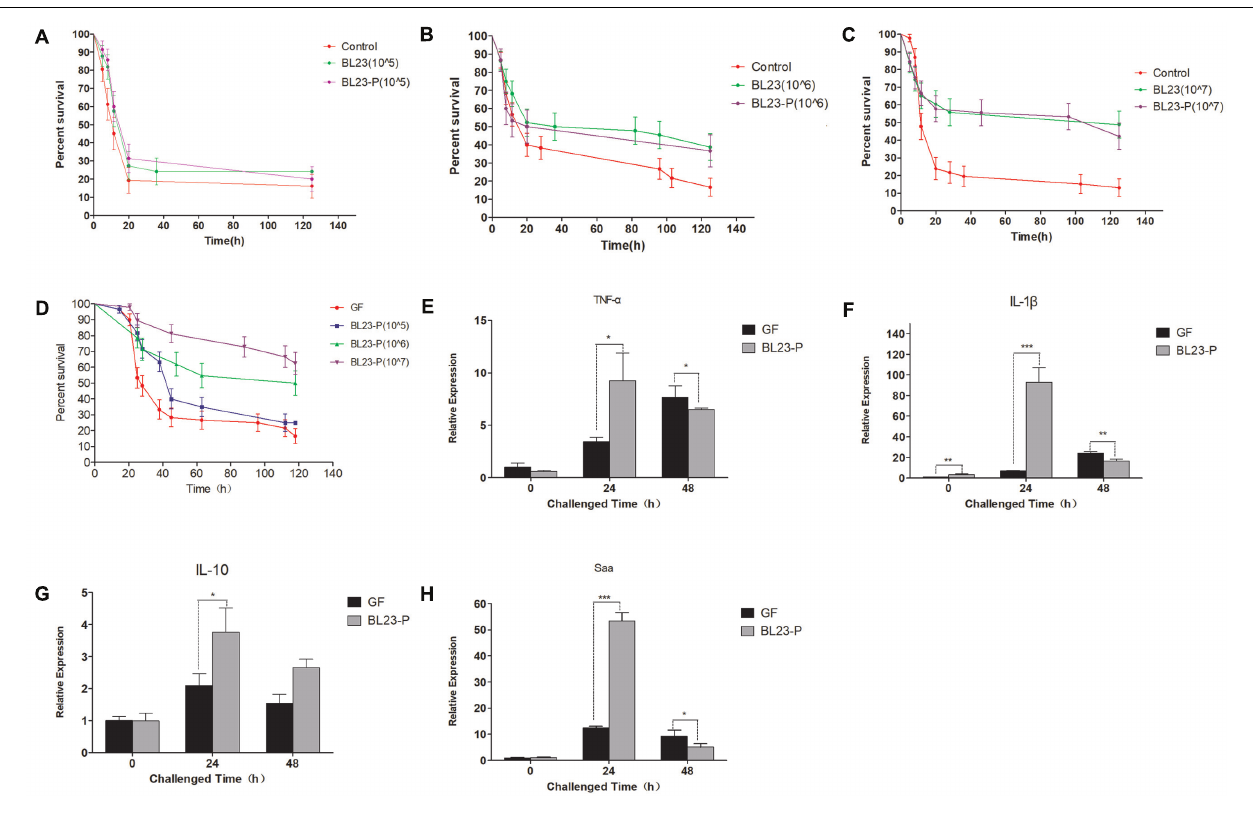
FIGURE 4 | Anti-infective activity of L. casei BL23 was mediated by some cellular structural components irrespective of cell viability. The survival rate (A) of conventional zebrafish larvae treated with live or dead cells of L. casei BL23 at a dose of 10 5 CFU/ml after infected with A. veronii . The survival rate (B) of conventional zebrafish larvae treated with live or dead cells of L. casei BL23 at a dose of 10 6 CFU/ml after infected with A. veronii . The survival rate (C) of conventional zebrafish larvae treated with live or dead cells of L. casei BL23 at a dose of 10 7 CFU/ml after infected with A. veronii . The survival rate (D) of GF zebrafish larvae treated with dead cells of L. casei BL23 at a dose of 10 5 , 10 6 , and 10 7 CFU/Ml, respectively after infected with A. veronii . The mRNA levels of TNF- α (E) , IL-1 β (F) , IL-10 (G) , and Saa (H) from GF and dead BL23 (10 6 CFU/mL) treated zebrafish at certain time points after infected with A. veronii . Asterisks indicate significant difference compared with control ( ∗ P < 0.05, ∗∗ P < 0.01, ∗∗∗ P < 0.001).